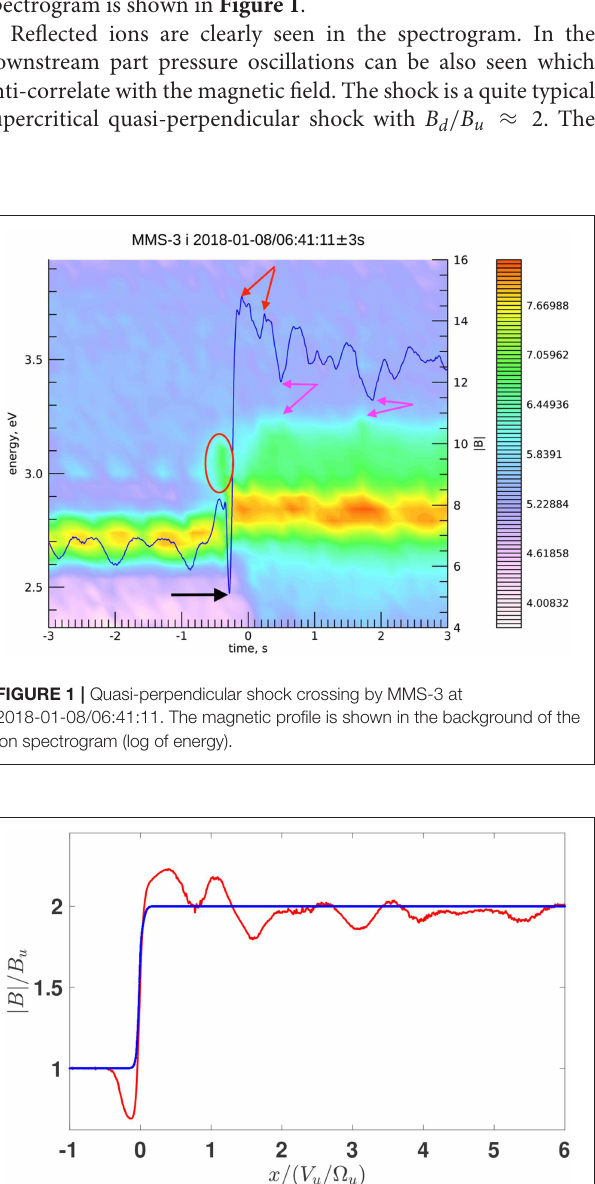
2.8, s NIF 0.55, and D 0.4( c /ω pi = = =